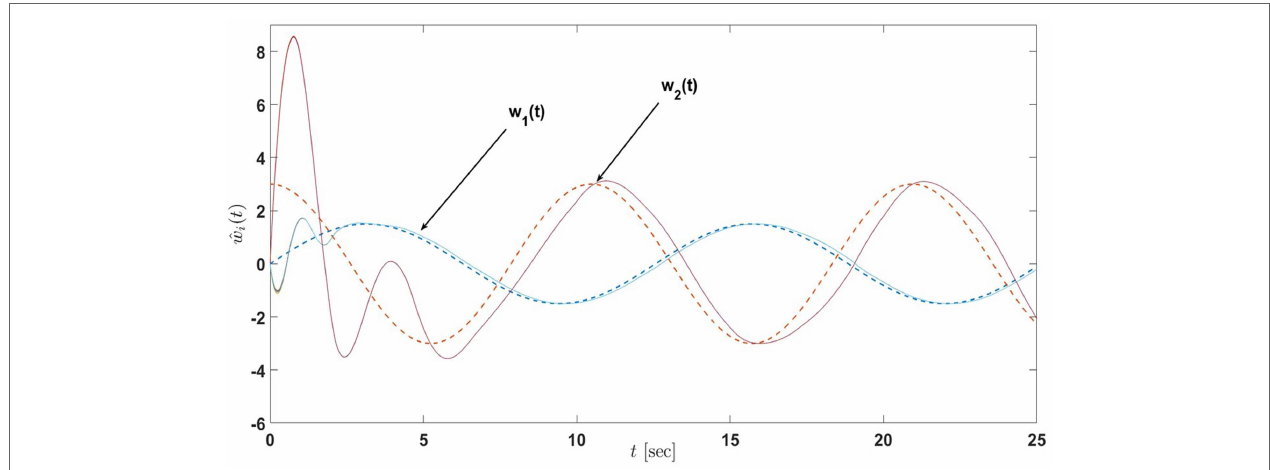
FIGURE 23 | Input estimates of the active-passive sensor network in Example 5 with 13 nodes under the proposed architecture equations (58) and (59) with the decrease in (cid:27) i , i = 1, :::; 12 (the dash lines denote the inputs of the actual process and the solid lines denote the input estimates of